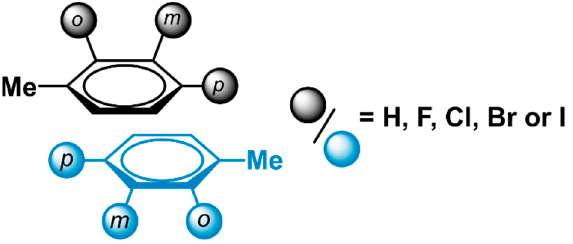
Figure 7. Parallel displaced, halogenated toluene dimers have previously been used to model the stacking interactions observed between phenylalanine residues [22].